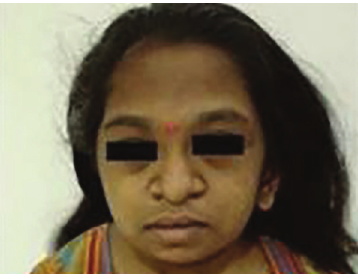
Figure 7 - X-ray picture of the skull in Hajdu-Cheney syndrome (there is an underdevelopment of the bones of the facial skull, protruding frontal and occipital tubercles, wide cranial sutures)